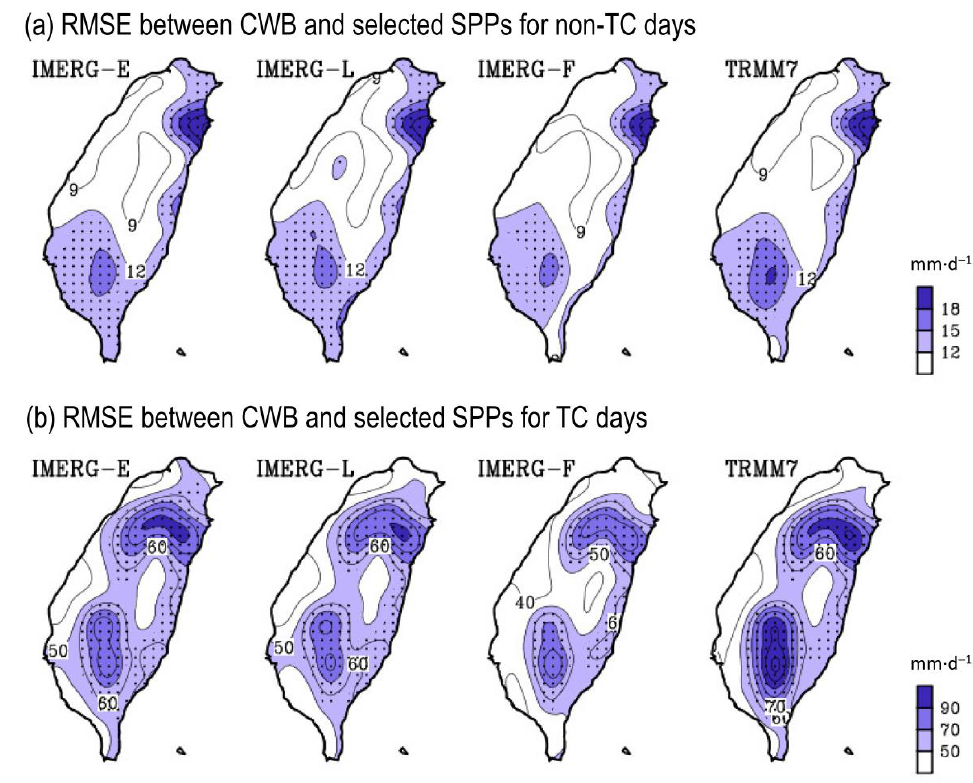
Figure 7. Spatial distribution for the RMSE between CWB and selected SPPs estimated from ( a ) non-TC days and ( b ) TC days, during 2000–2018 JASO. RMSE values that pass the 99% significance t -test are marked by dots.